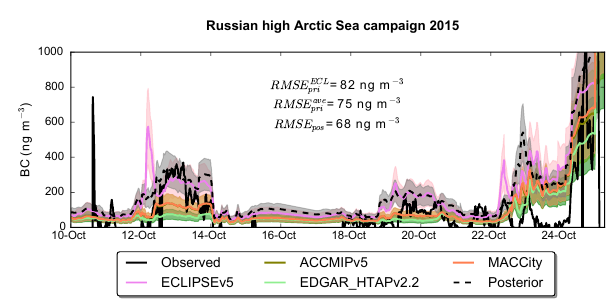
Figure 9. Comparison of prior (ECLIPSEv5, ACCMIPv5, EDGAR HTAPv2.2 and MACCity) and posterior simulated concentrations of BC (2015) with observations from a ship campaign in the Rus- sian Arctic in 2015 adopted from Popovicheva et al. (2017). The variability of the prior concentrations (shaded area) was calculated as the standard deviation of BC concentrations from the 12 species with different scavenging coefficients as shown in Table 2. Uncer- tainties of the posterior concentrations are due to scavenging and use of four different a priori datasets (Sect. 3.4). RMSE values are computed for ECLIPSEv5 concentrations, all prior concentrations (average) and posterior simulated BC